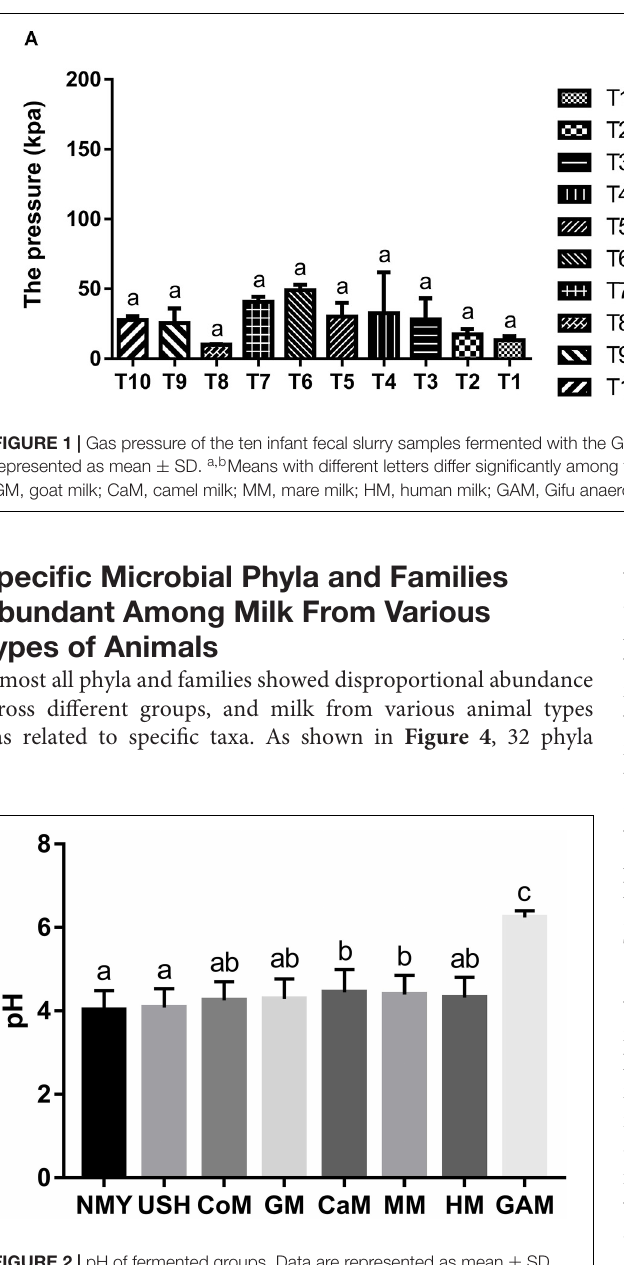
FIGURE 2 | pH of fermented groups. Data are represented as mean ± SD. a – c Means with different letters differ significantly among the groups ( p < 0.05). NMY and USH, infant formula powder; CoM, cow milk; GM, goat milk; CaM, camel milk; MM, mare milk; HM, human milk; GAM, Gifu anaerobic